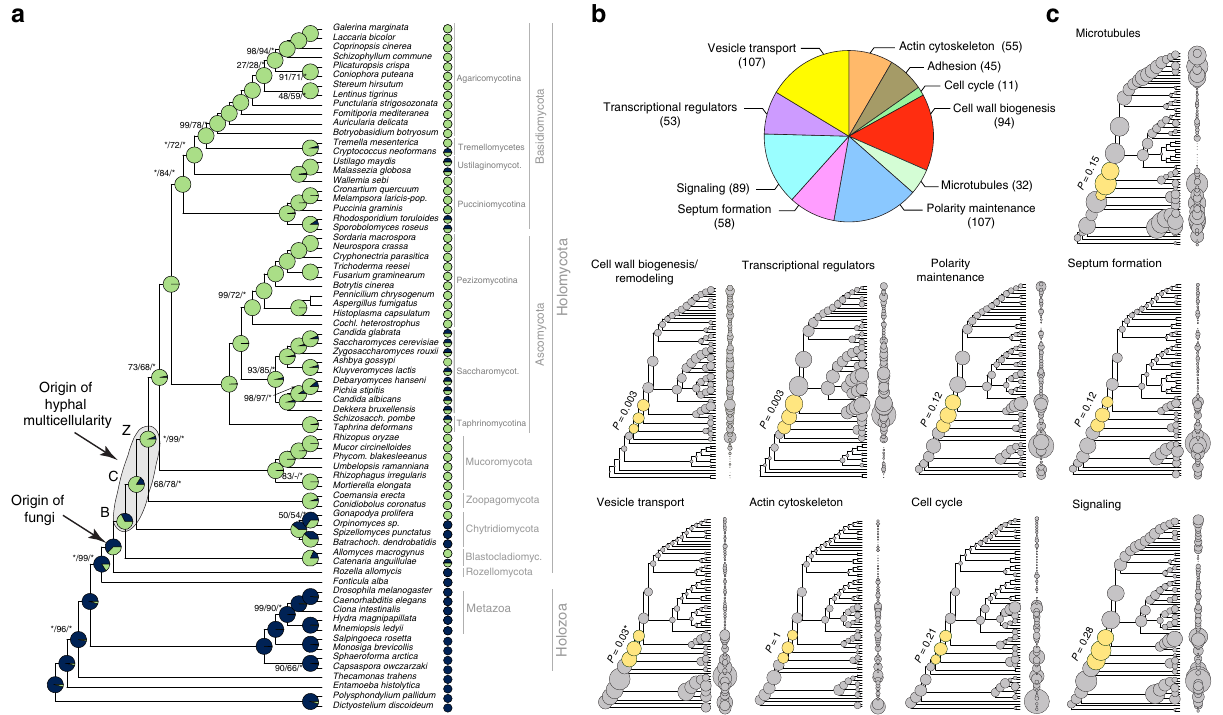
Fig. 1 The evolution of hyphal multicellularity and underlying genes in fungi. a Phylogenetic relationships among 72 species analyzed in this study. Pie charts at nodes show the proportional likelihoods of hyphal (green) and non-hyphal (dark blue) ancestral states reconstructed using Bayesian MCMC. Character state coding of extant species used in ancestral state reconstructions is shown next to species names. BCZ nodes: origins of hyphal growth could be assigned with con fi dence are highlighted (note the uncertainty imposed by fi lamentous Blastocladiomycota). Support values next to branches are given for nodes that received less than maximal support in at least one analysis. Support values are given as ML boostrap (RAxML)/ML bootstrap (IQ-Tree)/ Bayesian posterior probabilities (Phylobayes). Asterisk (*) denotes maximal support in a given analysis. b the distribution of literature-collected hypha morphogenesis genes among 10 main functional categories. c Ancestral reconstructions of gene copy number in 9 main hypha morphogenesis-related categories of genes (see Fig. 2c for adhesion). Bubble size is proportional to reconstructed ancestral gene copy number. BCZ nodes are shown in yellow. P -values of enrichment of duplications are shown next to each tree (Fisher ’ s exact test, FDR correction). *For vesicle transport the P -value indicates signi fi cant depletion of duplications in BCZ